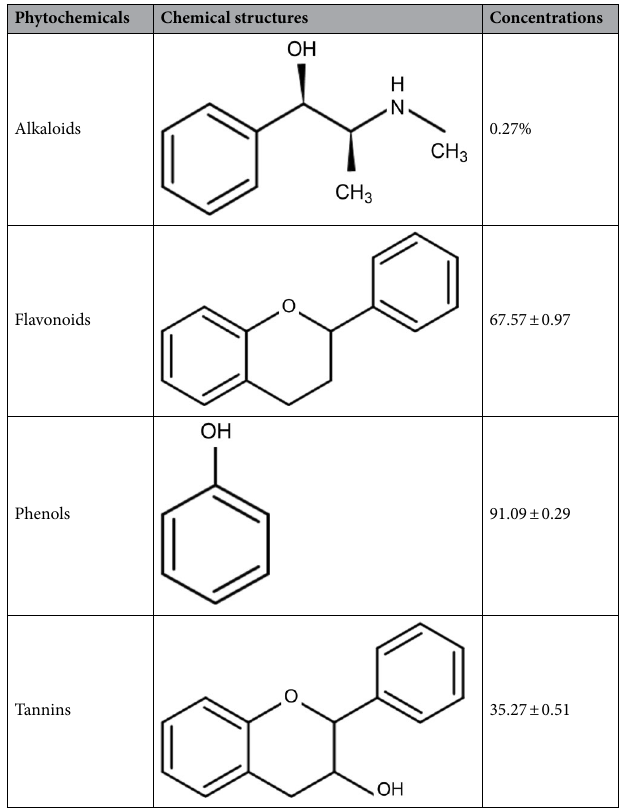
Table 2. Basic chemical structures and concentrations of W. somnifera roots methanolic extract bioactive constituents that positively influence the overall antioxidant activity of the extract. Concentration of alkaloids expressed as percent of dry weight; Concentrations of flavonoids, phenols, and tannins expressed as mean ± SEM microgram equivalents of respective standards per milligram of